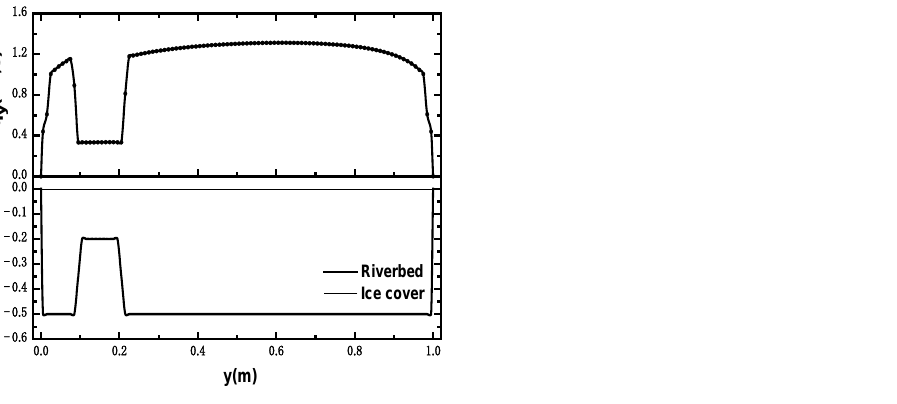
Figure 11. Section topography showing ice cover and riverbed distribution and cross-sectional relative-unit discharge in a channel section with two thalwegs.